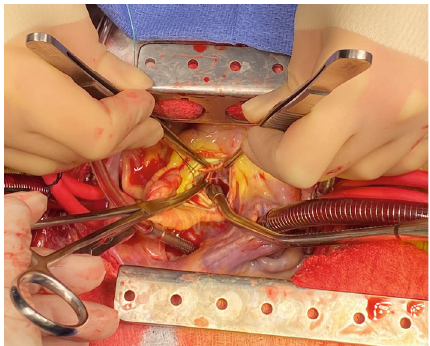
Figure 4: Intraoperative images showing the thin fi brotic subaortic membrane visible above the suction